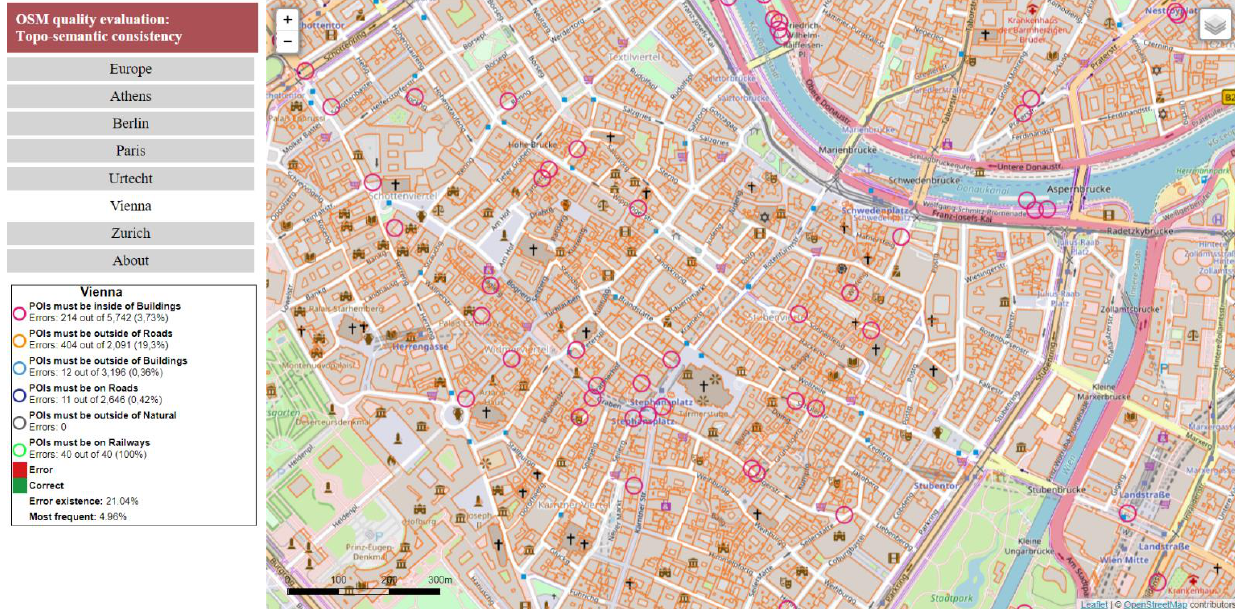
Figure A8. Errors from the topo-semantic consistency check “POIs must be inside of buildings” for Vienna. The “Buildings” layer is also portrayed.